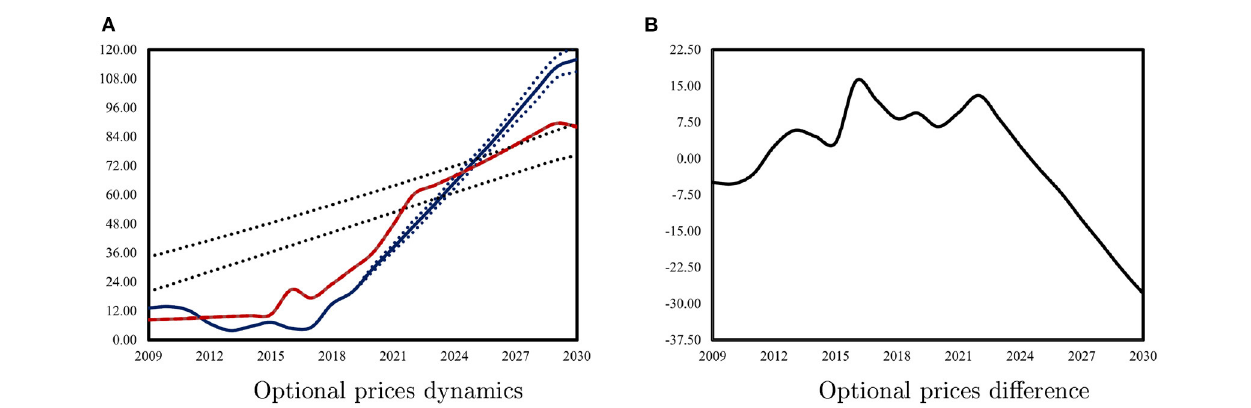
FIGURE 1 | ETS CO 2 -equivalent (tCO 2 e) price dynamics. The x -axis represents the time-line. The y -axis measures the option prices of carbon allowances. In (A) , the blue line corresponds to the levels of calls (optional purchasing prices). The blue dotted lines indicate the standard deviation of the calls. The red line corresponds to the levels of puts (optional selling prices). The black dotted lines depict the double-barrier optional values according to the public recommendations on carbon prices. (B) illustrates, through the black full line, the gap between puts and calls.